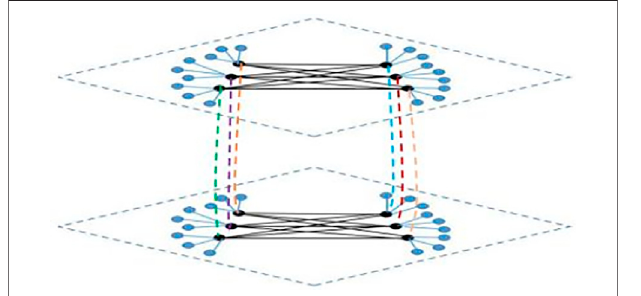
FIGURE 4 | An example of D , m (cid:1) 3, p (cid:1) 3.